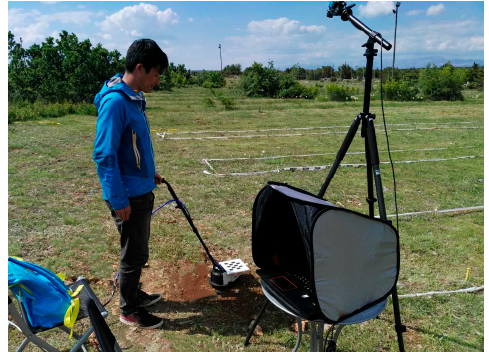
Figure 12. Field test in Croatia.